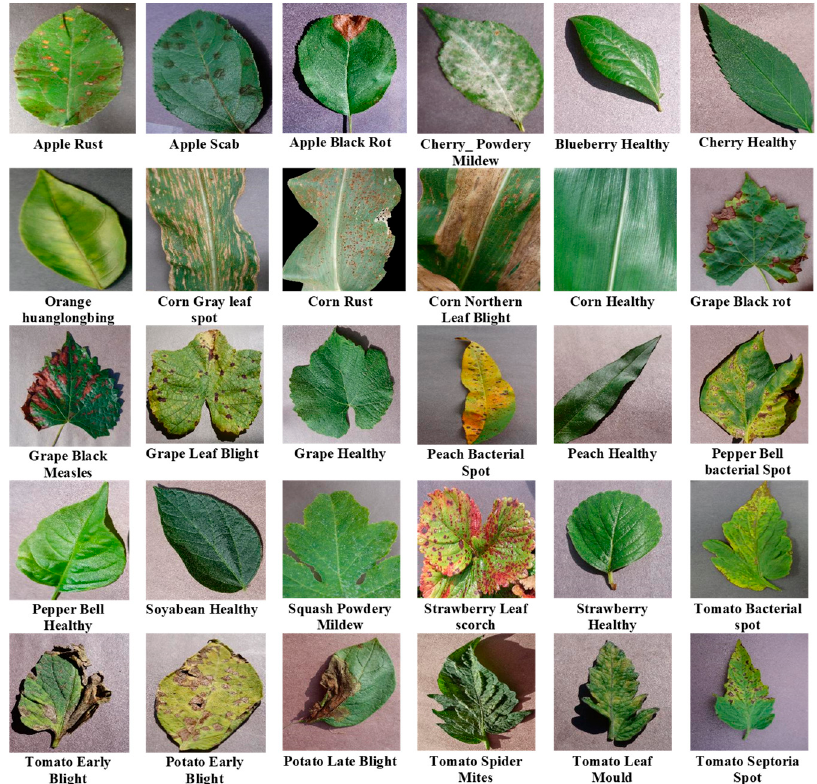
Figure 1. Sample images from PlantVillage dataset for 38 types of leaf diseases.